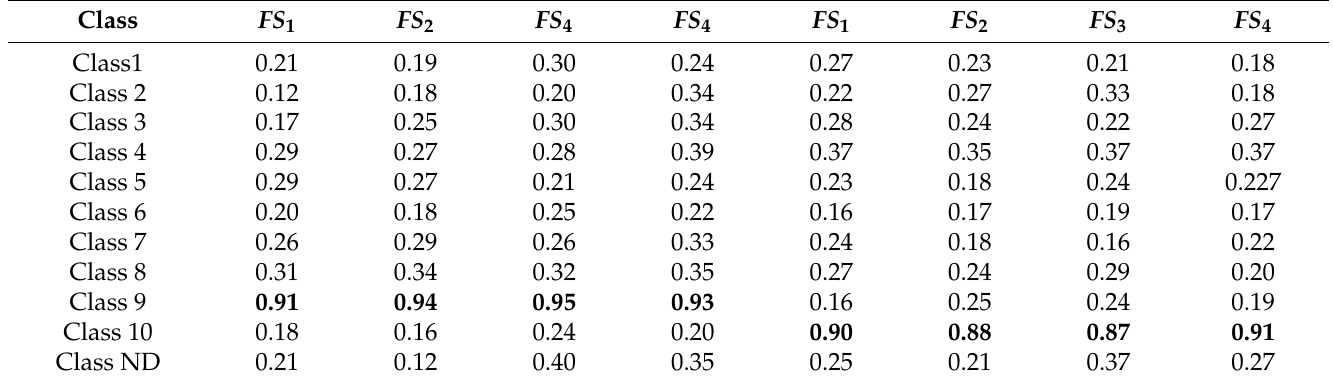
Table 9. FS 1 , FS 2 , FS 3 and FS 4 values obtained by comparing the EC maps of classes 9 and 10 with the remaining classes (the values highlighted in bold refer to the best performances).